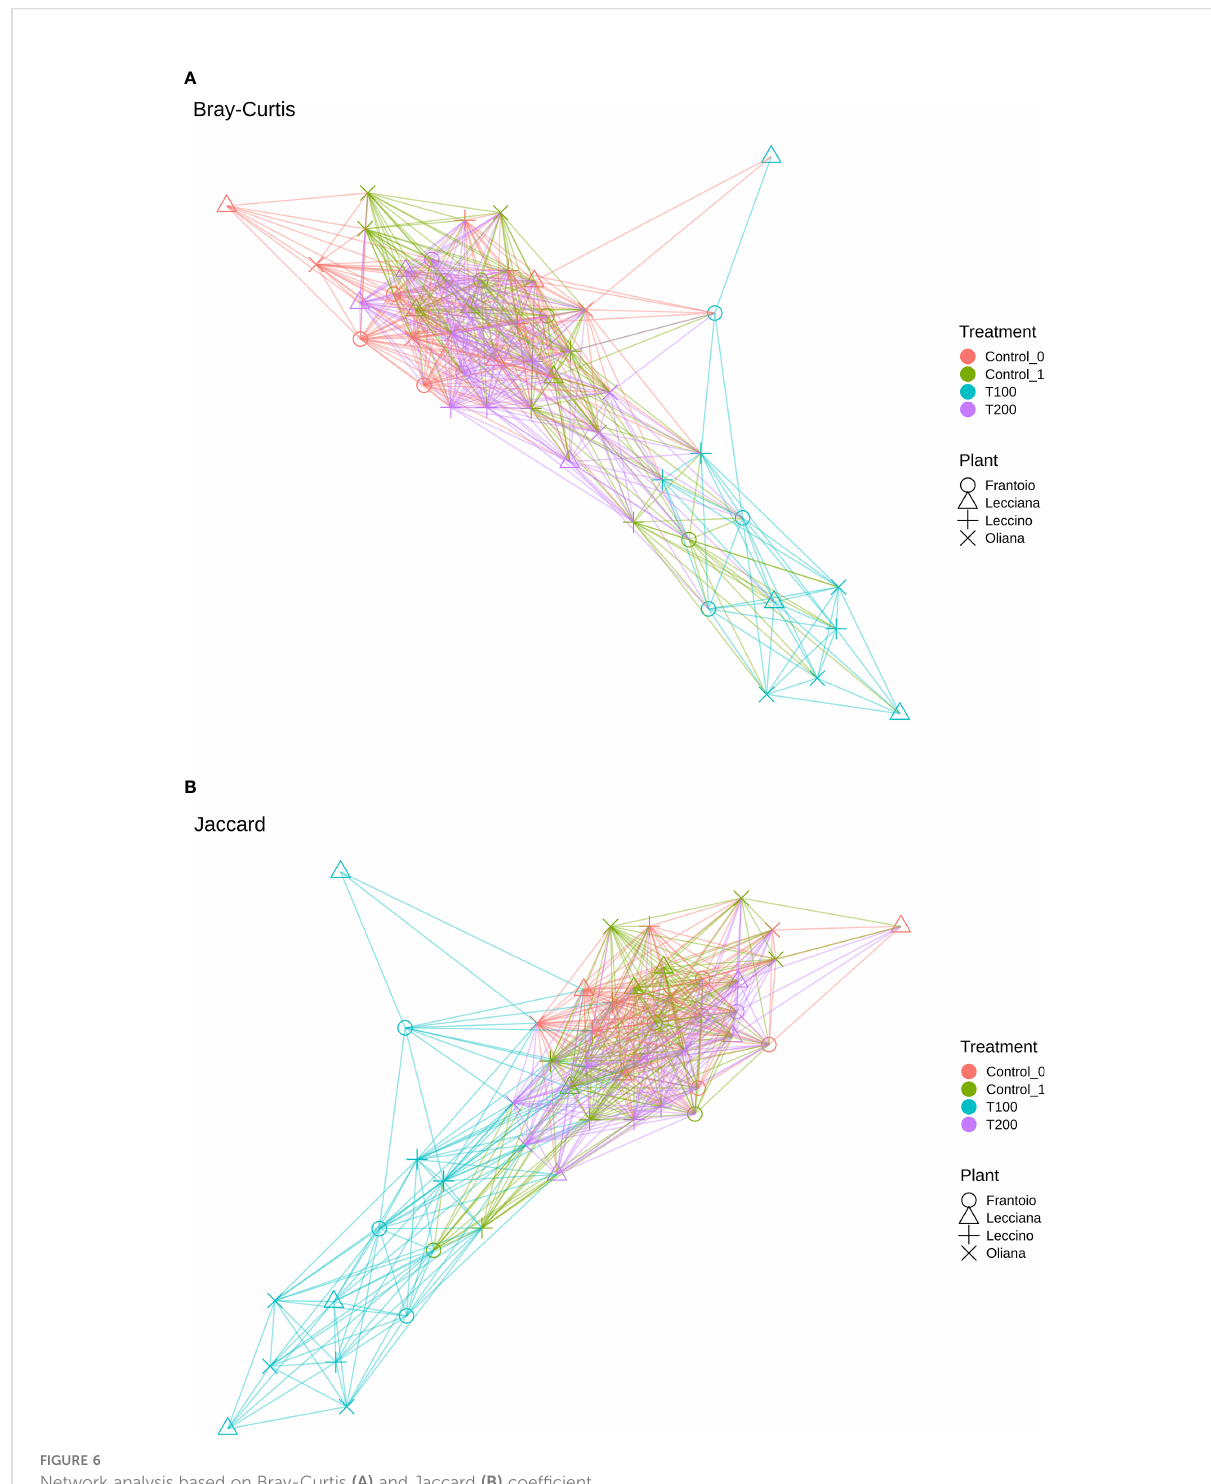
FIGURE 6 Network analysis based on Bray-Curtis (A) and Jaccard (B) coef fi